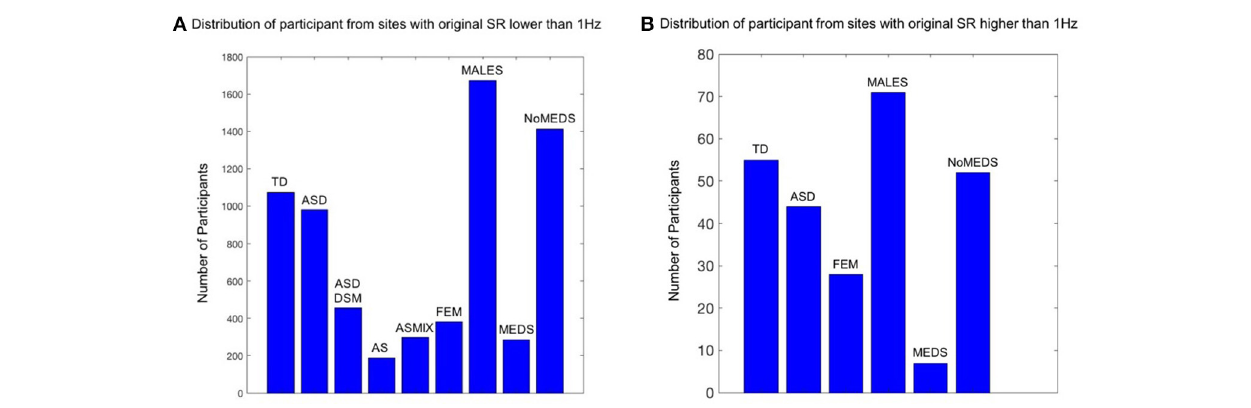
FIGURE 1 | Inclusion / Exclusion criteria for the ABIDE I and II data sets used in this study. (A) Participants from the sites from ABIDE I and ABIDE II which collected the fMRI data using a sample resolution lower than 1Hz. TD refers to typically developing participants (SR0 n = 1074; SR1 n = 55); ASD refers to Autism Spectrum Disorders according to the column 1 DSM of demographic records across ABIDE I and II (SR0 n = 982; SR1 n = 44). ASD DSM indicates those participants from the column 2 of demographic records with a DSM-IV-TR ASD diagnosis (SR0 n = 456); AS refers to the individuals from DSM-IV-TR with Asperger’s diagnosis of column 2 of demographics records (SR0 n = 189); ASMIX includes all AS, (Pervasive Developmental Disorder Not Otherwise Specified (PDDNOS), Pervasive Developmental Disorder (PDD) from column 2 DSM-IV (no ASD from DSM IV) (SR0 n = 298). FEM refers to all the female participants of demographic records across ABIDE I and II, despite the diagnosis they have (SR0 n = 384; SR1 n = 28); MALES are all male participants of demographics records, despite the diagnosis they have (SR0 n = 1673; SR1 n = 71); NoMEDS refers to all with a diagnosis of ASD (column 1 and 2 of the demographics records), all with a diagnosis of AS or PDDNOS or PDD who were not on medication (i.e., from all sites that reported medications) (SR0 n = 1414; SR1 n = 52). MEDS refers to all participants with any diagnosis but not on medication (SR0 n = 285; SR1 n = 7). (B) The same as (A) for participants from the sites which collected the fMRI data using a sample resolution higher than